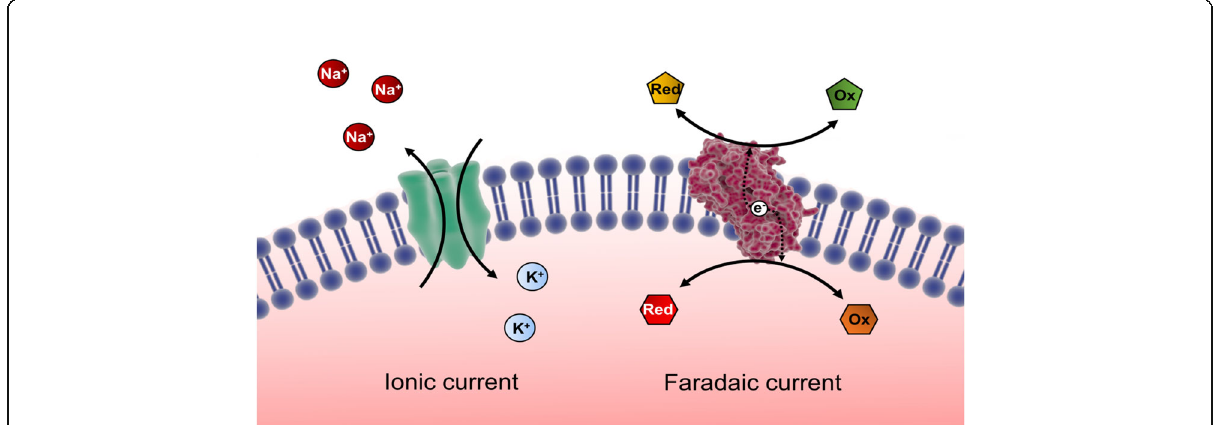
Fig. 1 Bulk ion vs faradaic conductance across the cell plasma membrane. Ionic currents are produced by the movement of charges across the membrane through the ionic channels, whereas faradaic currents are produced by the movement of electrons between electrochemical